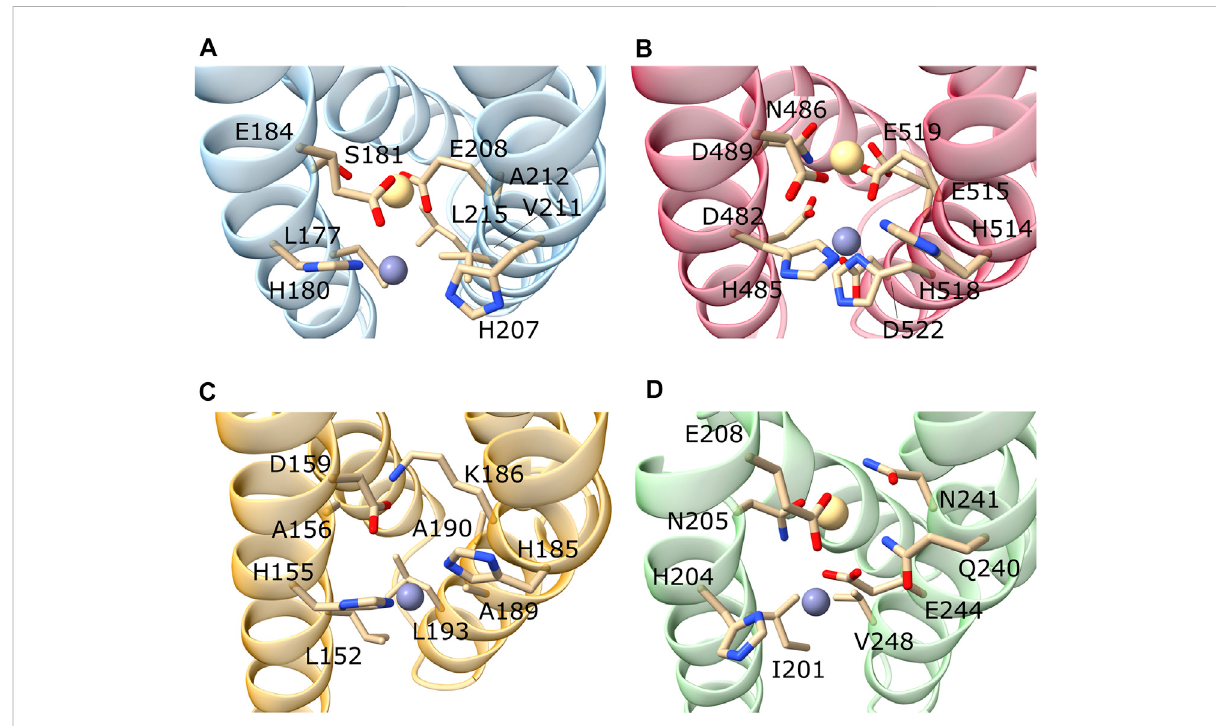
FIGURE 4 FocusontheM1andM2bindingsitesofrepresentativehZIPmembers.HerearerepresentedthepredictedM1andM2bindingsitesofhZIP3 (A) ; hZIP4 (B) ;hZIP9 (C) ;hZIP11 (D) .ThemetalionswereinsertedbysuperimposingthemodelsontotheBbZIPcrystalstructure.InthecaseofhZIP9,the metal in M2 was removed as K186 blocks the access to the metal binding site.